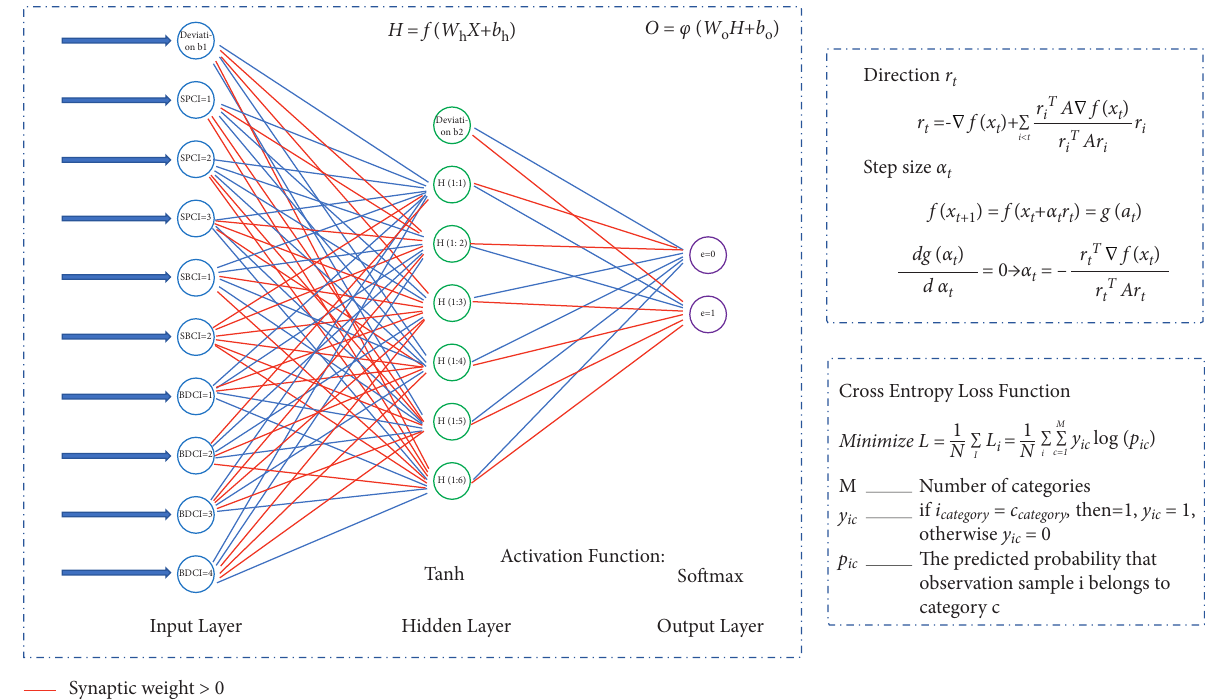
Figure 7: MLP neural network structure